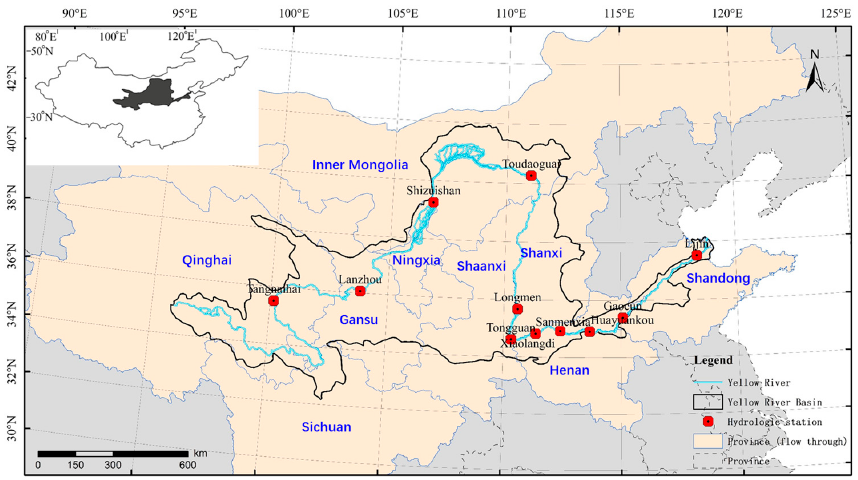
Figure 1. The location and administrative regions of Yellow River basin.